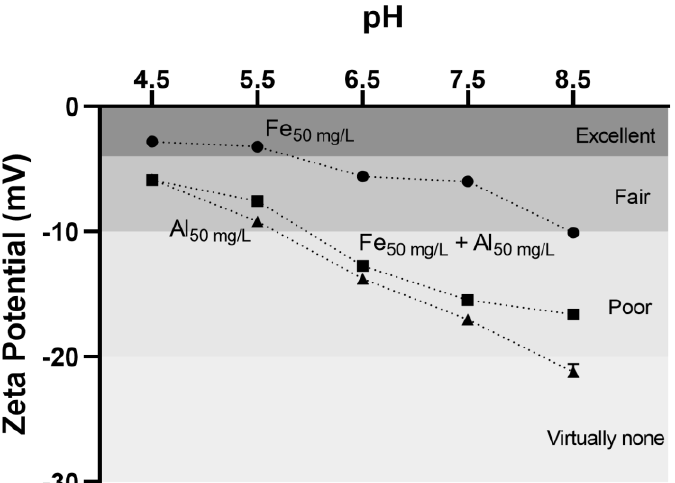
Figure 4. pH effect on zeta potential for iron, aluminum, and mixed suspensions (mean and range). Zones are colored according to the expected degree of coagulation of particles: excellent, fair, poor, and virtually none (categories proposed by [48]). Suspensions at lower pH are closer to the isoelectric point, within the zone of particle instability (excellent and fair areas).